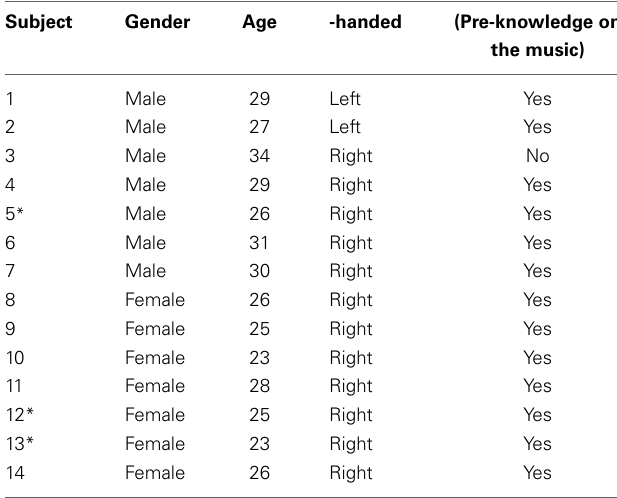
Table 1 | 14 Subjects in